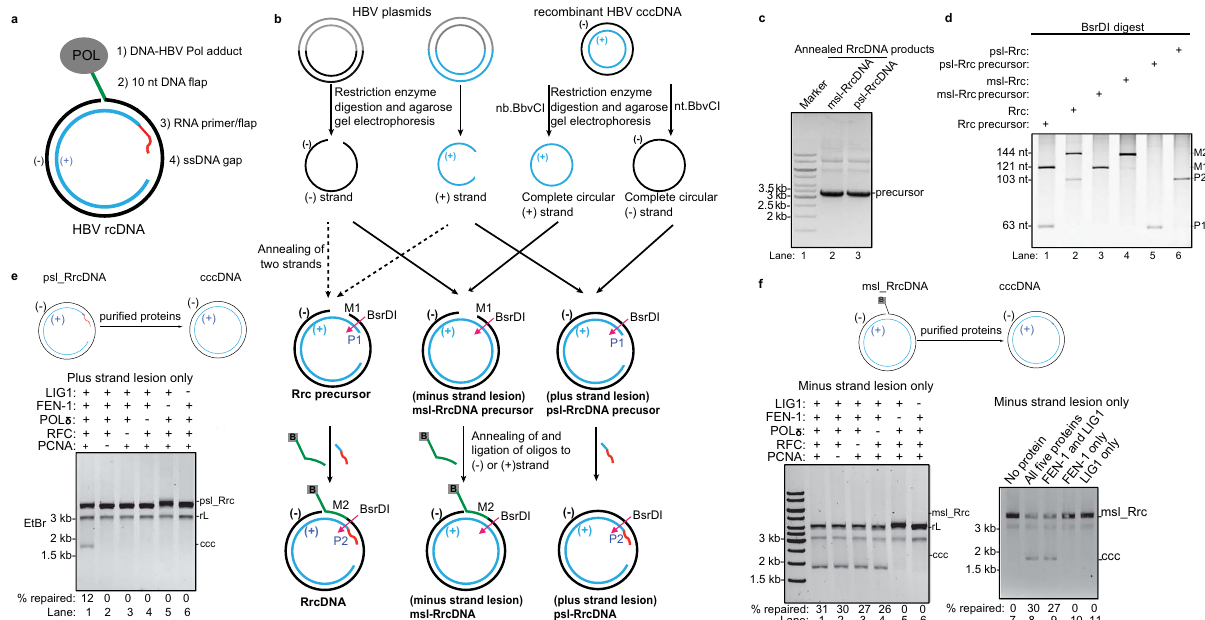
Fig. 1 Repair of HBV lesions on plus- and minus-strands require different sets of protein factors. a Characteristics of HBV rcDNA structure. b Schematic representation of the generation of recombinant HBV rcDNA (RrcDNA) substrates that contain all lesions (RrcDNA) or only lesions on the plus- (psl- RrcDNA) or minus-strands (msl-RrcDNA). HBV plasmids contains a plasmid backbone (gray) and either the minus strand sequence (black) or the plus- strand sequence (blue). BsrDI cleavage was used to monitor the generation of various RrcDNA substrates (BsrDI restriction sites are indicated by magenta arrows); green line, biotinylated fl ap; B, biotin; red line, RNA primer. Note that M1 and M2 are two oligos released from the minus-strands of RrcDNA precursor and RrcDNA after BsrDI digestion, whereas P1 and P2 are two oligos released from the plus-strands after BsrDI digestion. c Annealing products of psl-RrcDNA and msl-RrcDNA precursors were monitored by Sybr Safe staining. d Generation of various RrcDNA precursors was analyzed by formation of M2 and P2 oligos from the corresponding M1 and P1 oligos after BsrDI digestion and urea-PAGE gel electrophoresis followed by Sybr Gold staining. Please note that psl-RcDNA and msl-RrcDNA only contain annealed oligos on the plus-strand and minus strand, respectively. Almost complete conversion from P1 to P2 (psl-RcDNA, lanes 5 – 6), and M1 to M2 (msl-RcDNA, lanes 3 – 4) was observed. e All fi ve human protein factors are required for repair of the lesions on the plus-strand. Psl-RrcDNA was mixed with combinations of puri fi ed proteins, and cccDNA formation was detected on agarose gels containing ethidium bromide (EtBr). Omission of factors is indicated by “ − ” . f FEN-1 and LIG1 are necessary and suf fi cient for repair of lesions on the minus strand. Omission of factors is indicated by “ − ” . The percentage of cccDNA formed (% repaired) was calculated by dividing the intensity of the ccc band by the sum of the intensities of the RrcDNA, linear RrcDNA and cccDNA bands. The absolute values are displayed above each lane number. Rrc, RrcDNA; rL, recombinant linear RrcDNA; ccc, cccDNA. All experiments were repeated twice with the same results. Source data are provided as a Source Data fi